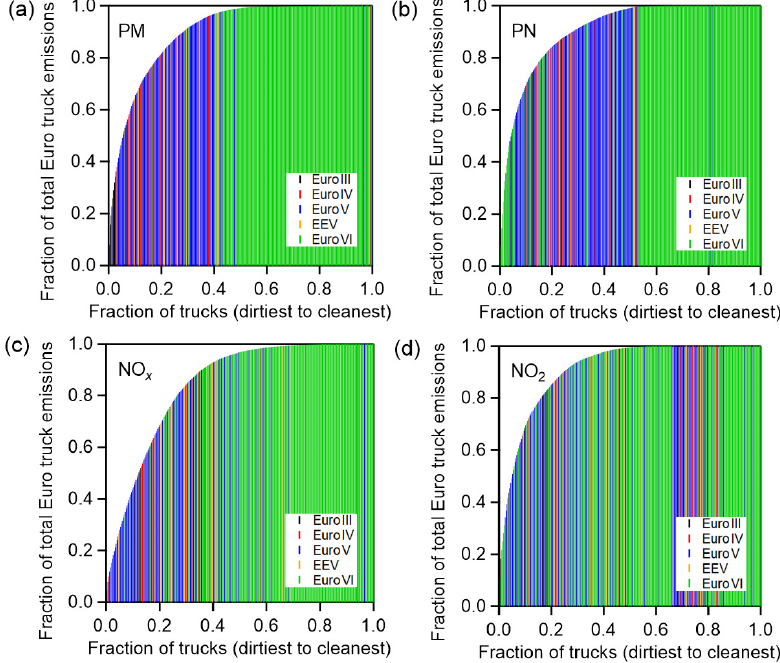
Figure 5. Cumulative emission factor distribution for (a) PM, (b) PN, (c) NO x , and (d) NO 2 measured in HDT exhaust plumes with HDTs ranked from the highest to lowest in terms of emission